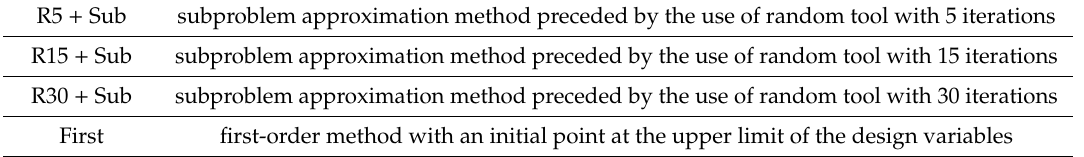
Table 5. Optimization methods